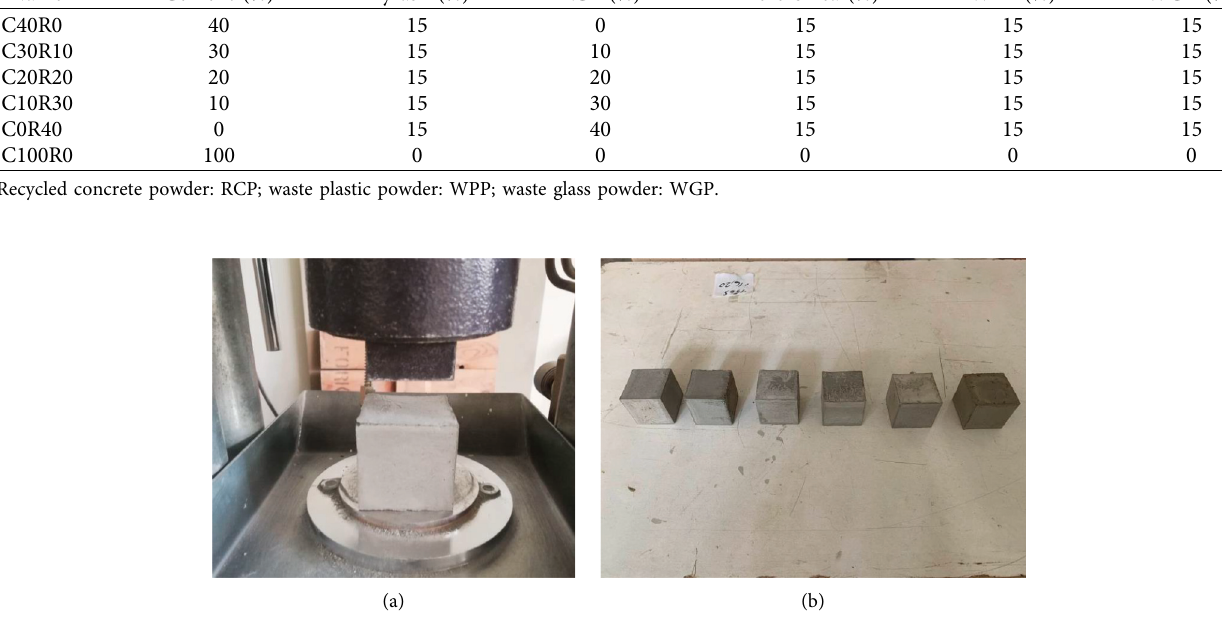
Figure 4: Compressive strength: (a) test machine and (b) cubic specimens. Table 10: Compressive